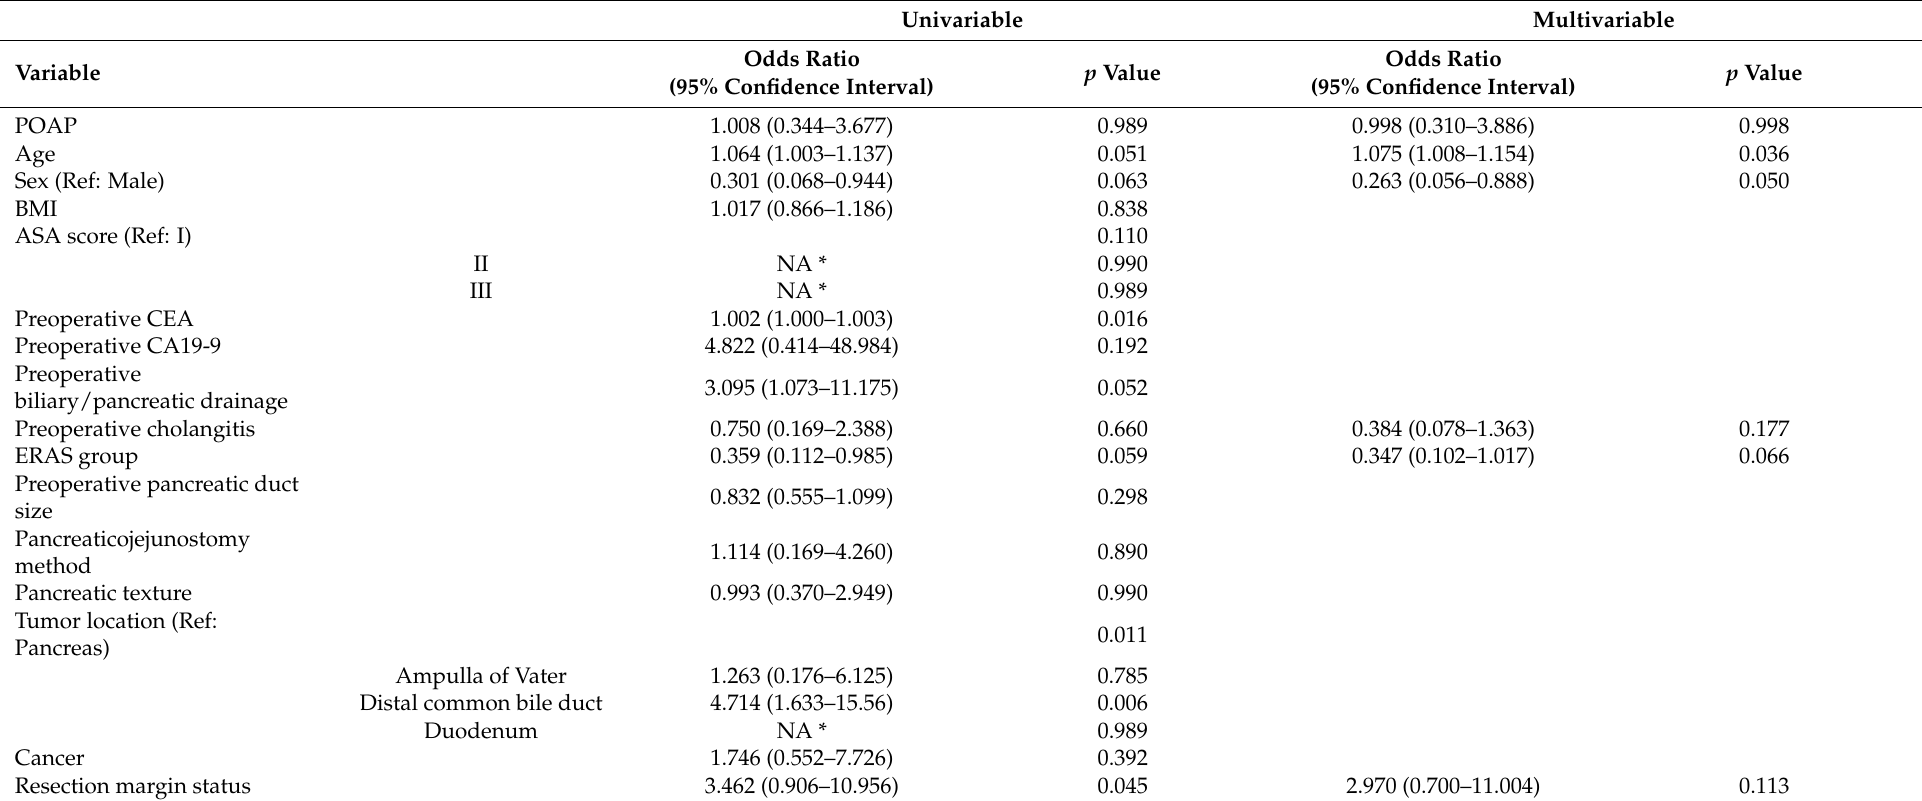
Table 5. Univariable and multivariable analyses of clinically relevant postoperative pancreatic fistula (CR-POPF) after backward elimination by forcing the inclusion of POAP. Univariable